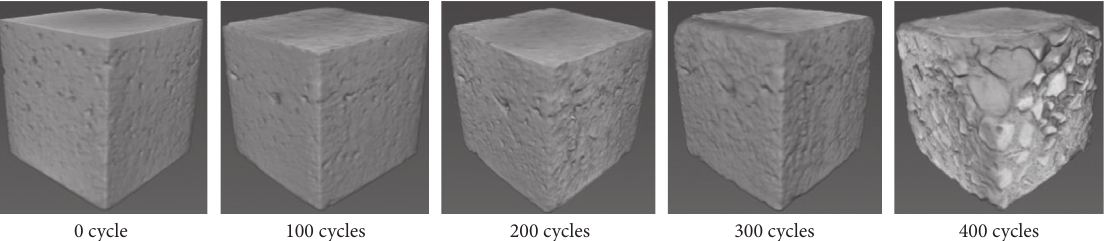
Figure 11: Profile of 6% CaO expansive concrete (C-6) under different freeze-thaw cycles.